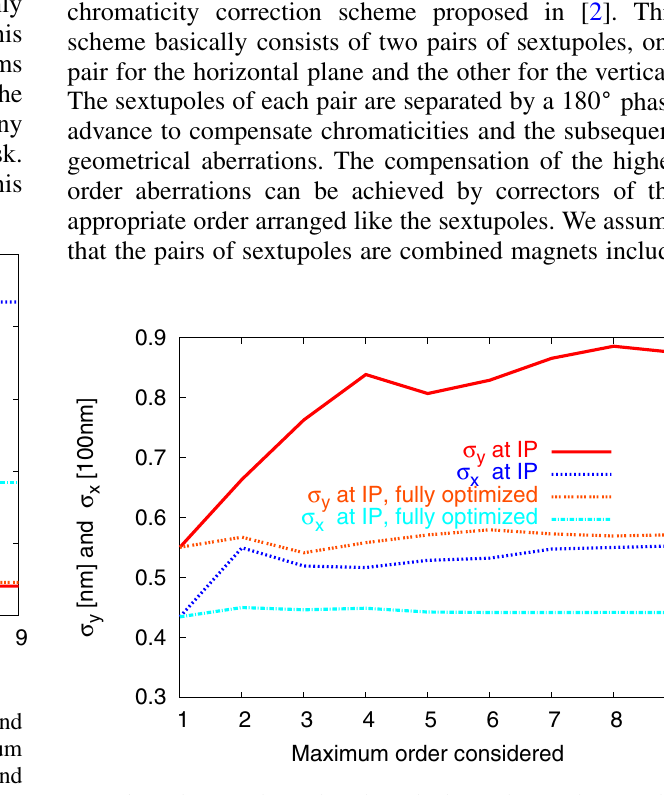
FIG. 5. (Color) Horizontal and vertical rms beam sizes at the CLIC IP for the nominal BDS and the one fully optimized.